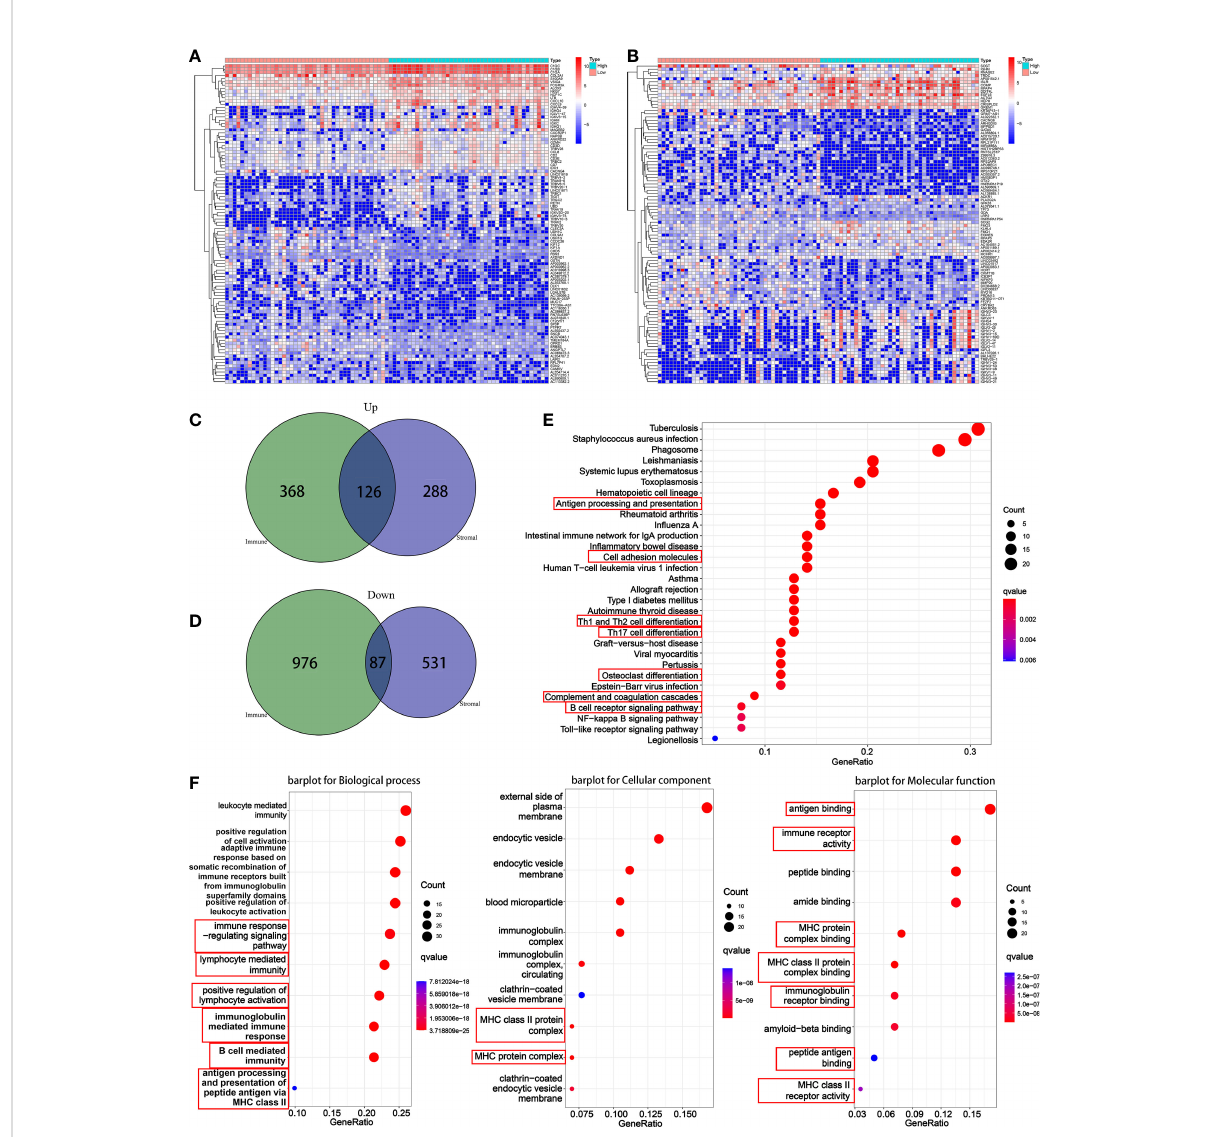
FIGURE 3 Differential analysis and enrichment analysis based on immune score and stromal score. (A) A heatmap for the top 50 up-regulated DEGs and the top 50 down-regulated DEGs by comparison of the high immune score group to the low immune score group. (B) A heatmap for the top 50 up-regulated DEGs and the top 50 down-regulated DEGs by comparison of the high stromal score group to the low stromal score group. (C) A venn diagram showed common up-regulated DEGs. (D) A venn diagram showed common down-regulated DEGs. (E) KEGG enrichment analysis based on overlapped DEGs. (F) GO enrichment analysis based on overlapped